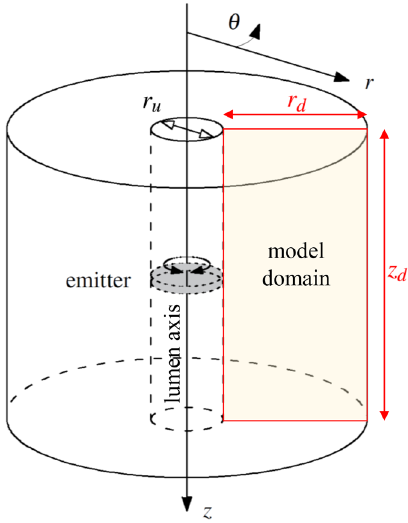
Figure 2. Geometry and system of coordinates used in the wave propagation model. The grey disk represents a rotational emitter placed within the lumen. Spatial domain of the axisymmetric model contoured in red. r d , z d and r u are defined in Table 1. Source : Gomez et al. 4